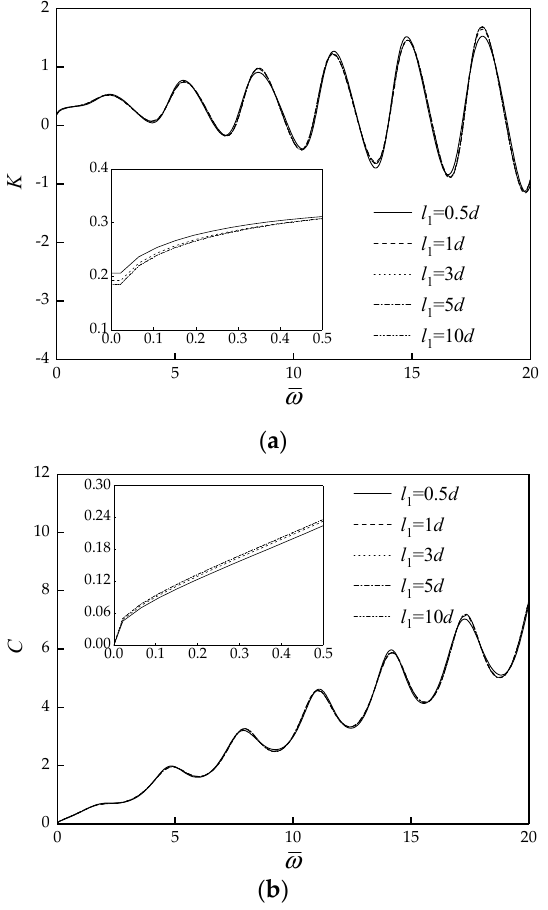
Figure 3. Effect of PES thickness on the vertical dynamic impedance of pile. ( a ) Dynamic stiffness curves; ( b ) Dynamic damping curves.